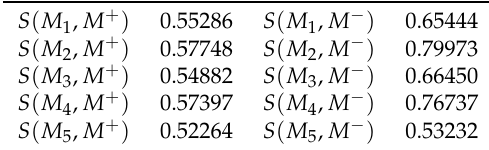
Table 6. The proposed similarity measure S